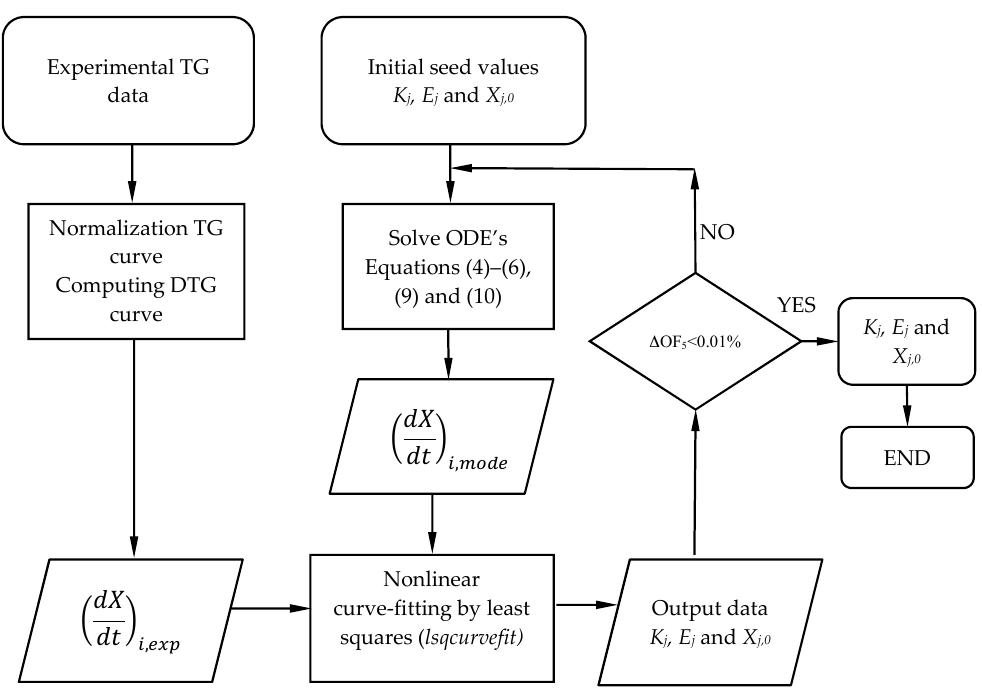
Figure 1. Decision tree of the calculation procedure.